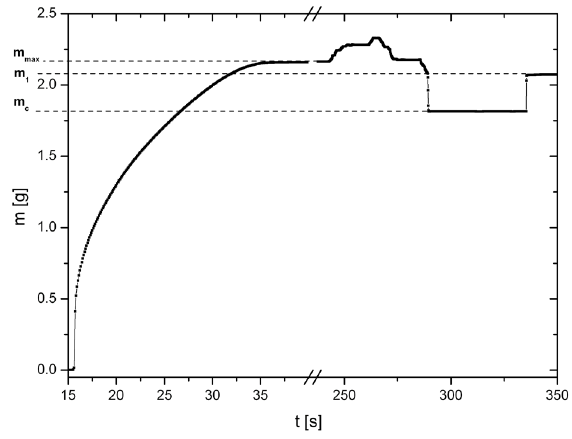
Figure 5: Typical measured dependence of mass on time, where: - mass of water + constant influence of meniscus + influence m max of elongation of meniscus; m constant influence of meniscus.